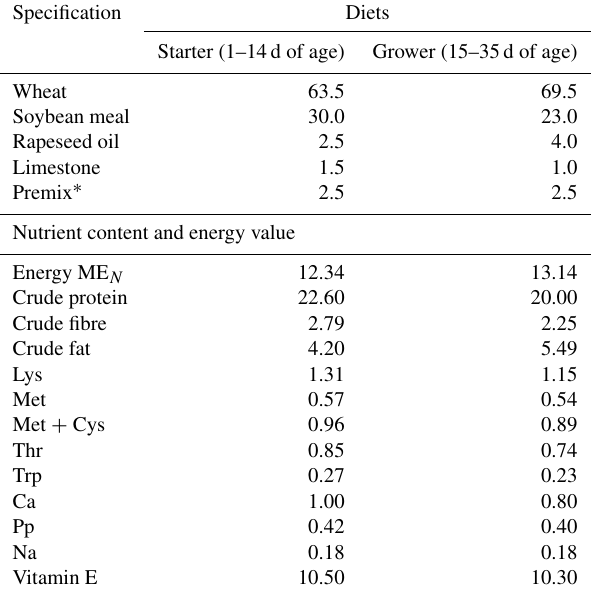
Table 2. Composition (%), content of vitamin E (mgkg − 1 ) and en- ergy value (ME N MJkg − 1 ) of broiler chicken